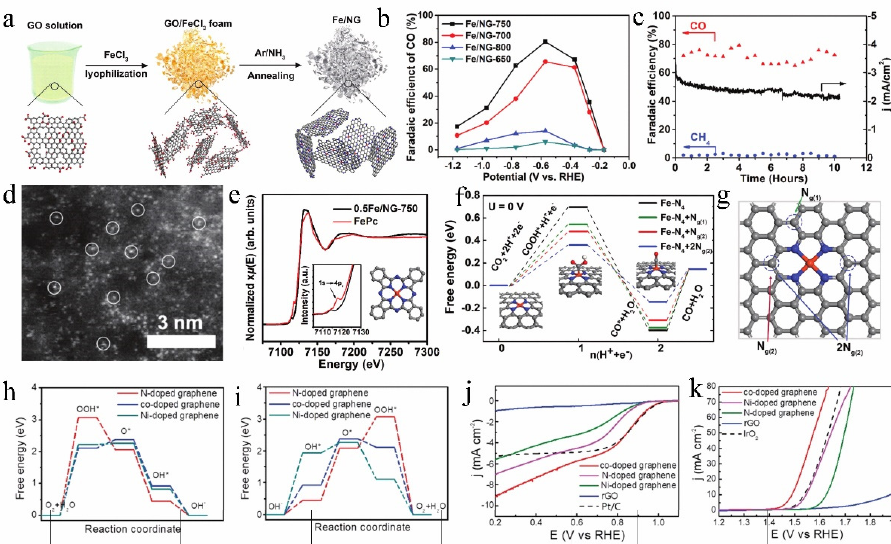
Figure 9. ( a ) Schematic of the synthesis process of the Fe/NG catalyst. ( b ) Potential dependence of CO FE for electrochemical CO 2 reduction on Fe/NG catalysts prepared at different annealing temperatures (in aqueous 0.1 m KHCO 3 ). ( c ) Chronoamperometric curves of stability test with Fe/NG-750 at − 0.60 V versus RHE in the CO 2 -saturated 0.1 M KHCO 3 solution. ( d ) HAADF-STEM images of Fe/NG − 750 catalyst. ( e ) Normalized Fe K edge XANES spectra of 0.5Fe/NG-750 catalyst (black line) and FePc reference (red line); the inset shows the enlarged view of pre-edge features. ( f ) Free energy diagram for electrochemical CO 2 reduction to CO on FeN 4 moieties embedded on graphene sheets. ( g ) Top view of the optimized structures for Fe-N 4 moieties embedded on graphene layer and potential nitrogen-substitution. Reproduced with permission [125]. Copyright 2018, Wiley-VCH. Free energy diagrams for ( h ) the ORR and ( i ) OER processes. ( j ) ORR polarization curves of different electrodes in O 2 -saturated 0.1 M KOH. ( k ) OER polarization curves of different electrodes in 1.0 m KOH . Reproduced with permission [129]. Copyright 2019, Wiley-VCH.